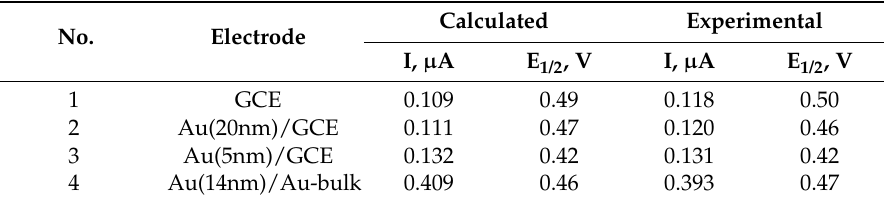
E 1/2 —half-wave potential of UA oxidation.